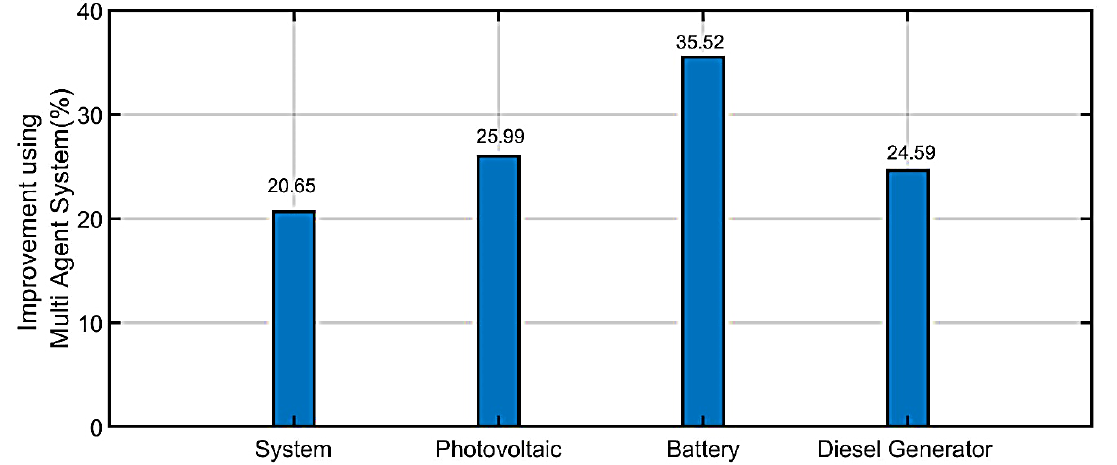
Figure 16. Comparison between power loss without proposed method and with proposed method.